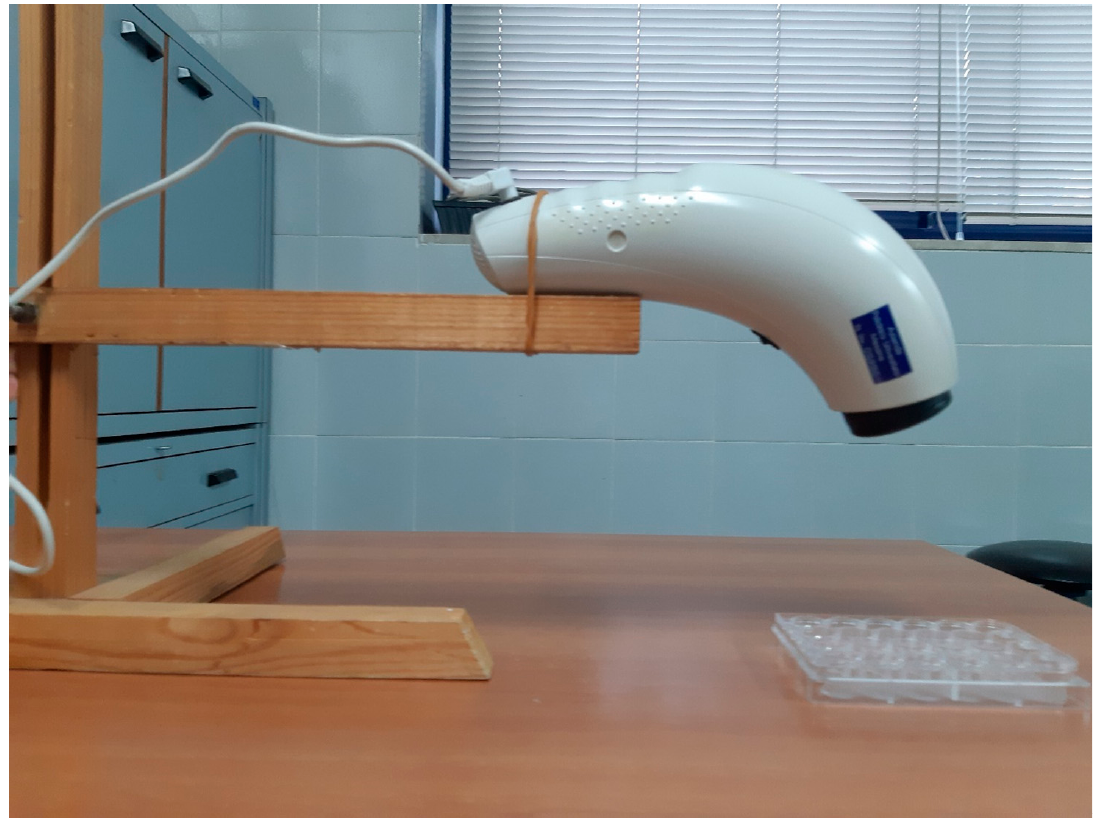
Figure 1. Bioptron lamp.